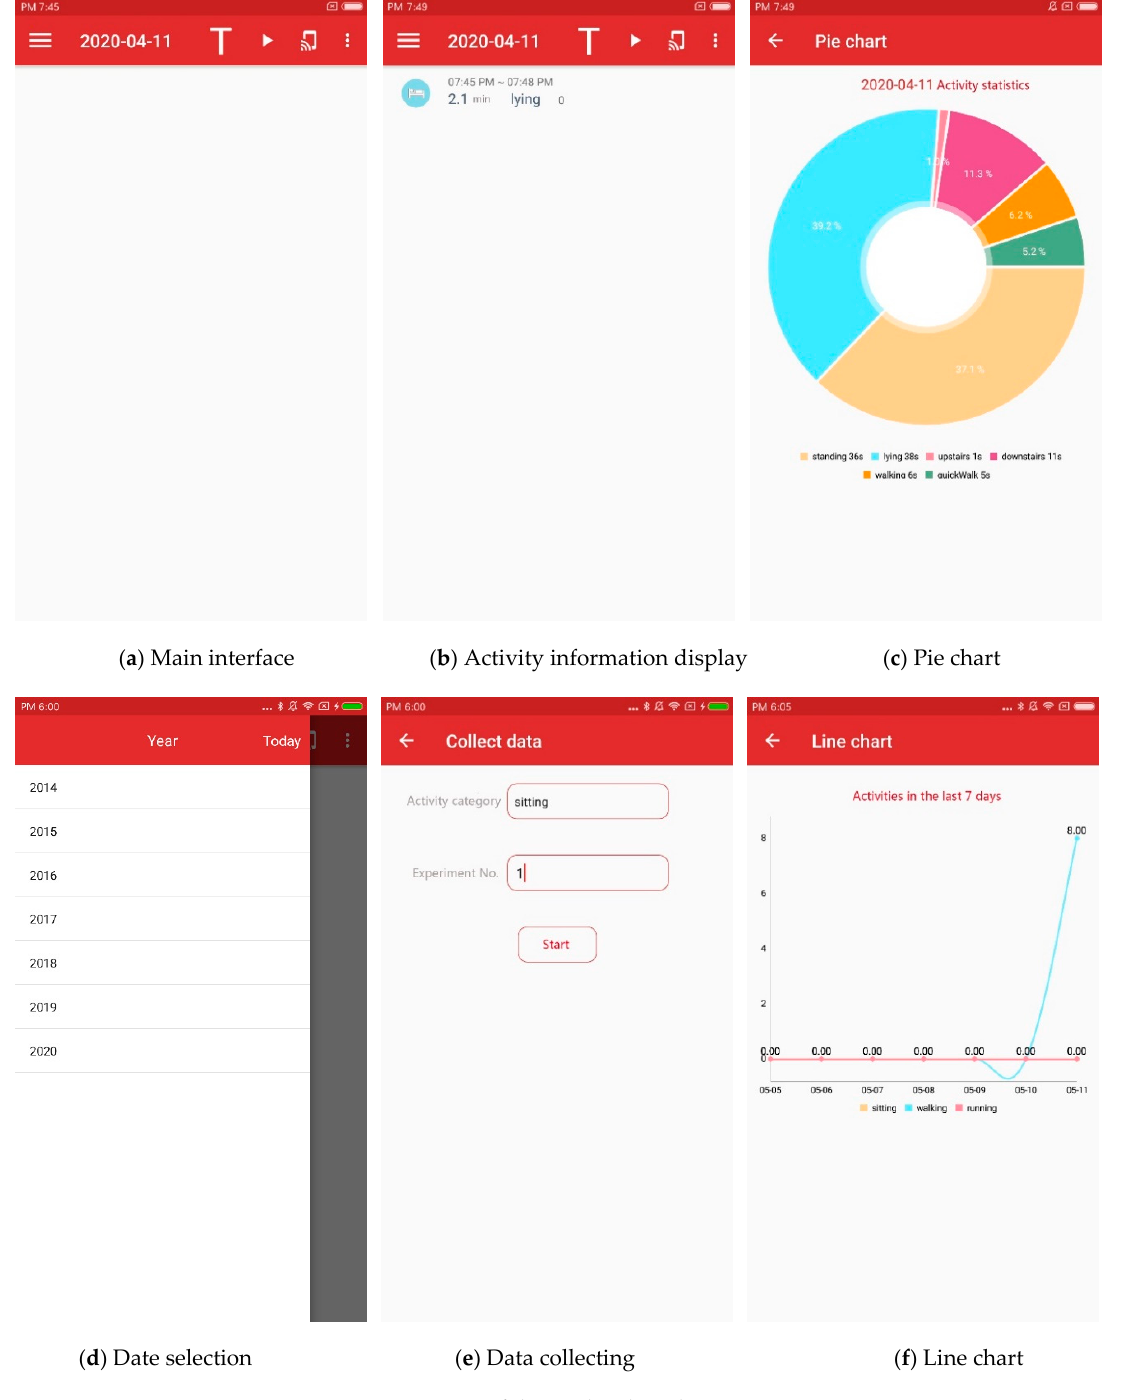
Figure 5. UI of the Android application.